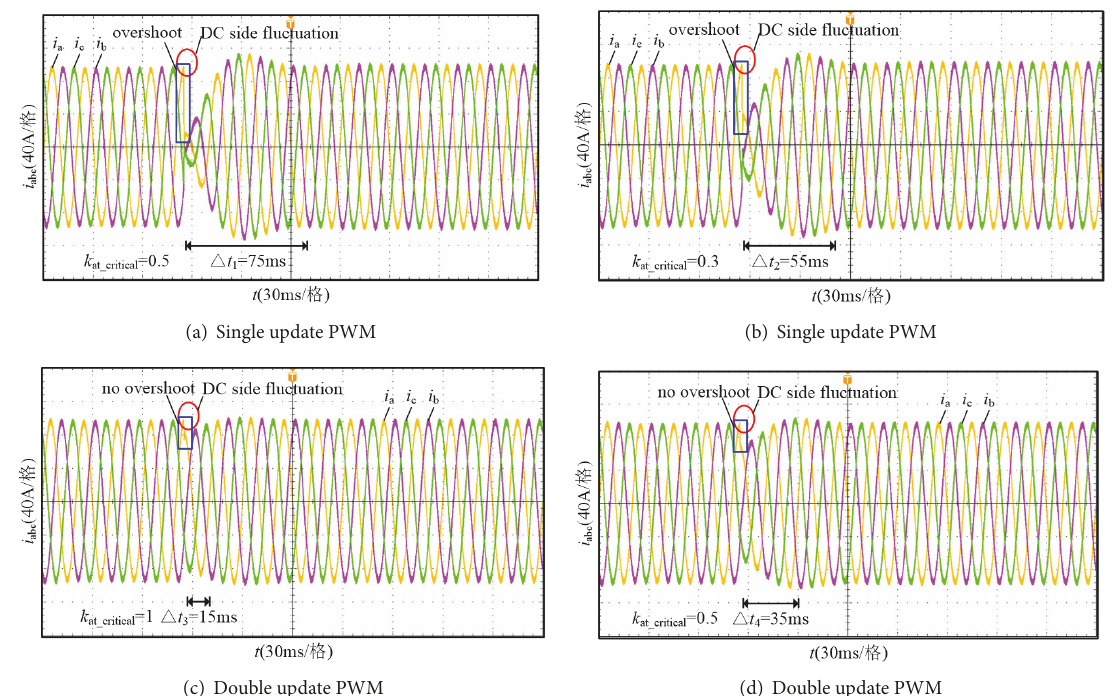
Figure 23: Contrast analysis of dynamic experimental waveforms between the single update PWM and proposed